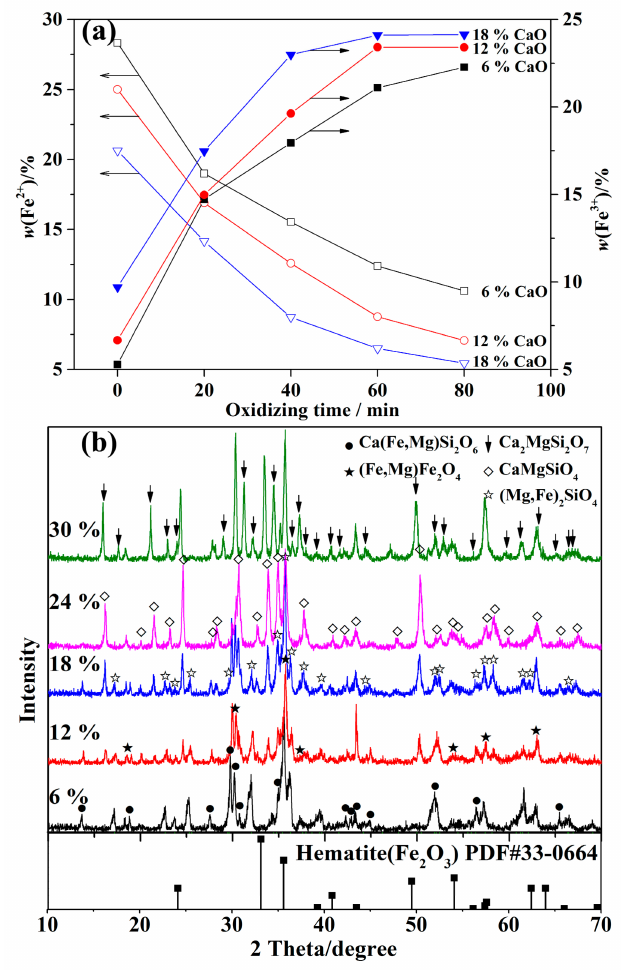
Figure 5. ( a ) Effects of CaO content on the iron state variation and ( b ) X-ray diffraction (XRD) patterns of